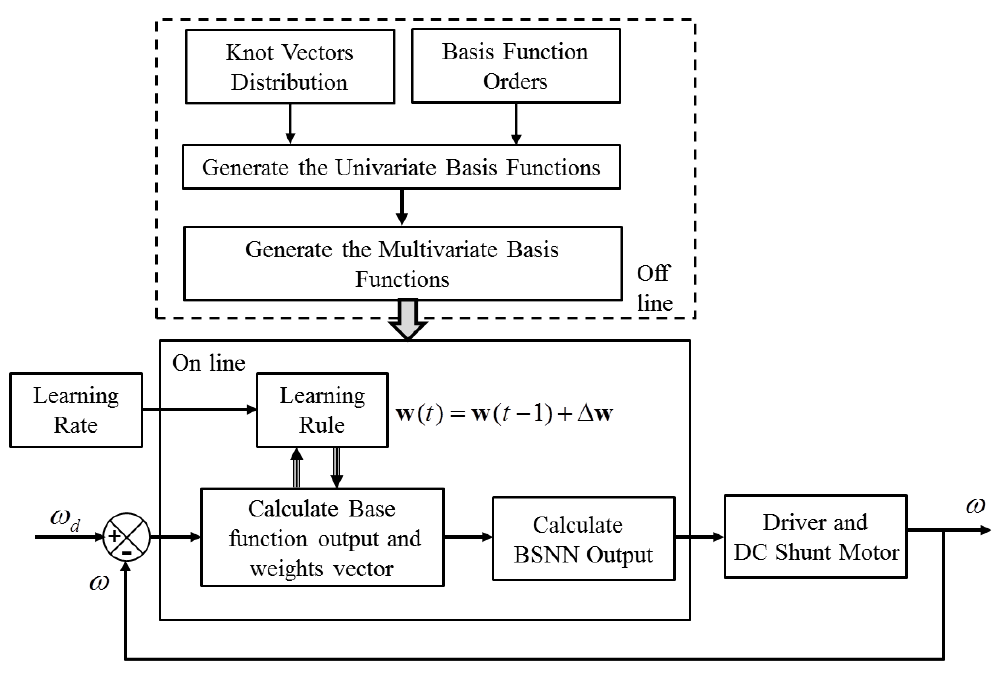
Figure 4. Block diagram of the BSNN controller for DC shunt motors.